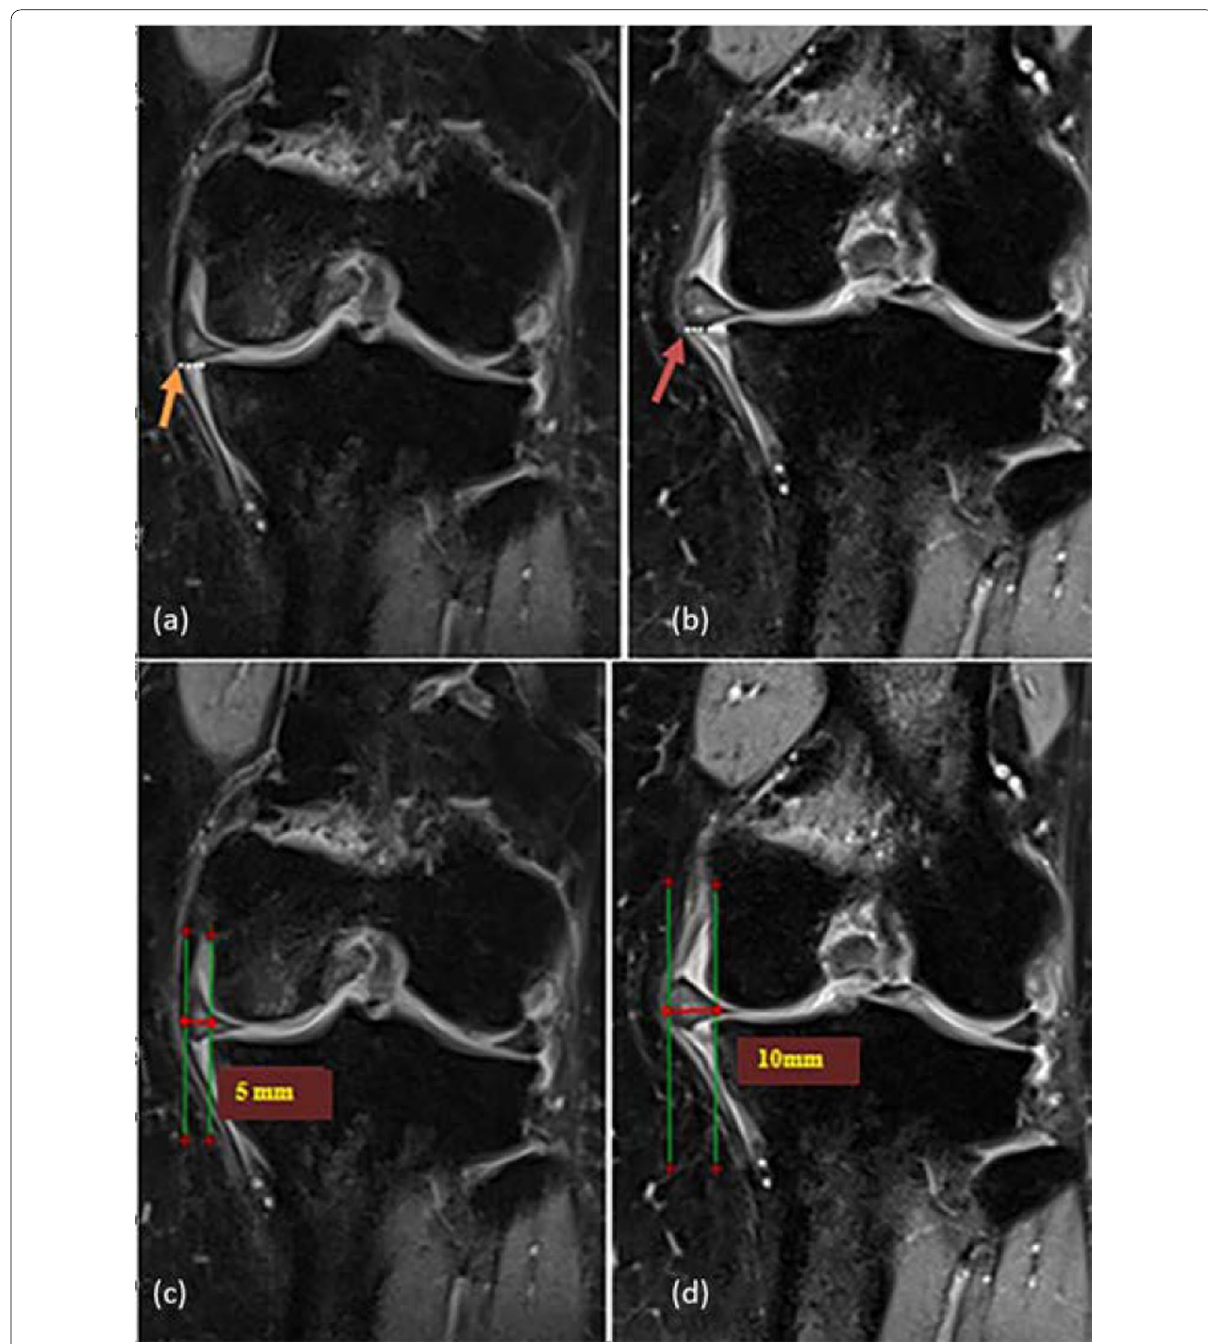
Fig. 5 MRI of the same patient: comparison between the pre‑ and post‑varus stress medial meniscus extrusion amount (MME) ( c ). Without varus stress position (left upper and left lower), the coronal PD‑SPAIR WI of the left knee shows an extruded medial meniscus of approximately 5 mm (from the end of the medial tibial plateau to the end of the extruded meniscus) (orange arrow). With varus stress position (right upper and right lower), MME increased up to 10 mm from the end of the medial tibial plateau to the end of the extruded meniscus (red